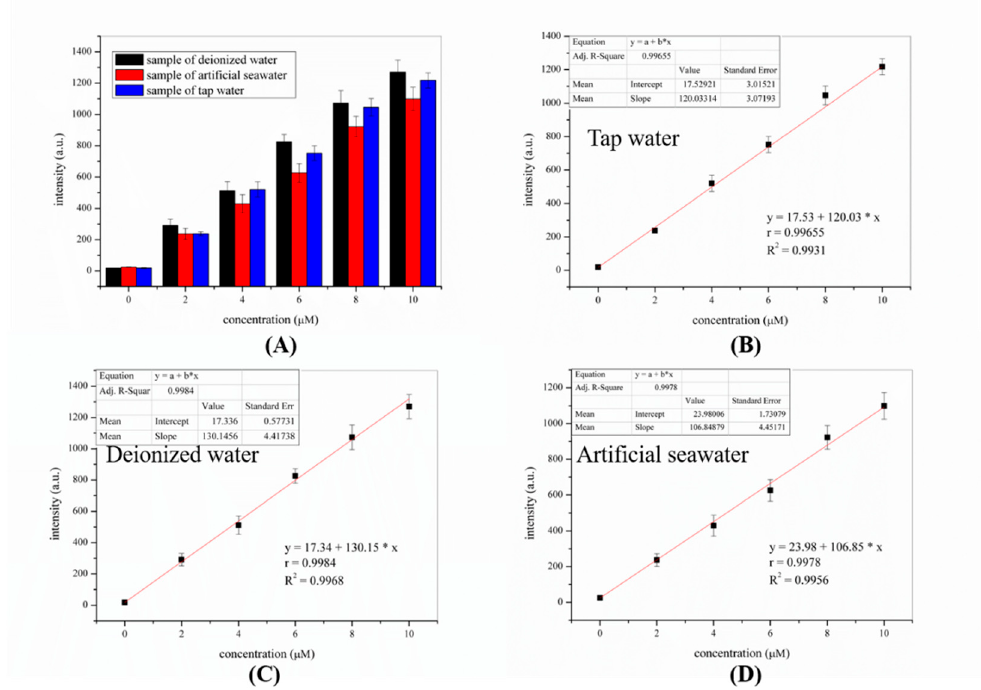
Figure 5. A linear calibration curve between the fluorescence intensities of probe-KCP and concentration of 4-methoxythiophenol in the range of 0–10 µ M in real water samples. ( A ) Fluorescent detection of different concentrations of 4-methoxythiophenol in “tap water”, “deionized water”, and “artificial water” by probe-KCP (10 µ M) in PBS buffer (20 mM) with 50% DMSO; ( B – D ) Linear of fluorescence intensity changes of probe-KCP against the of 4-methoxythiophenol for real water